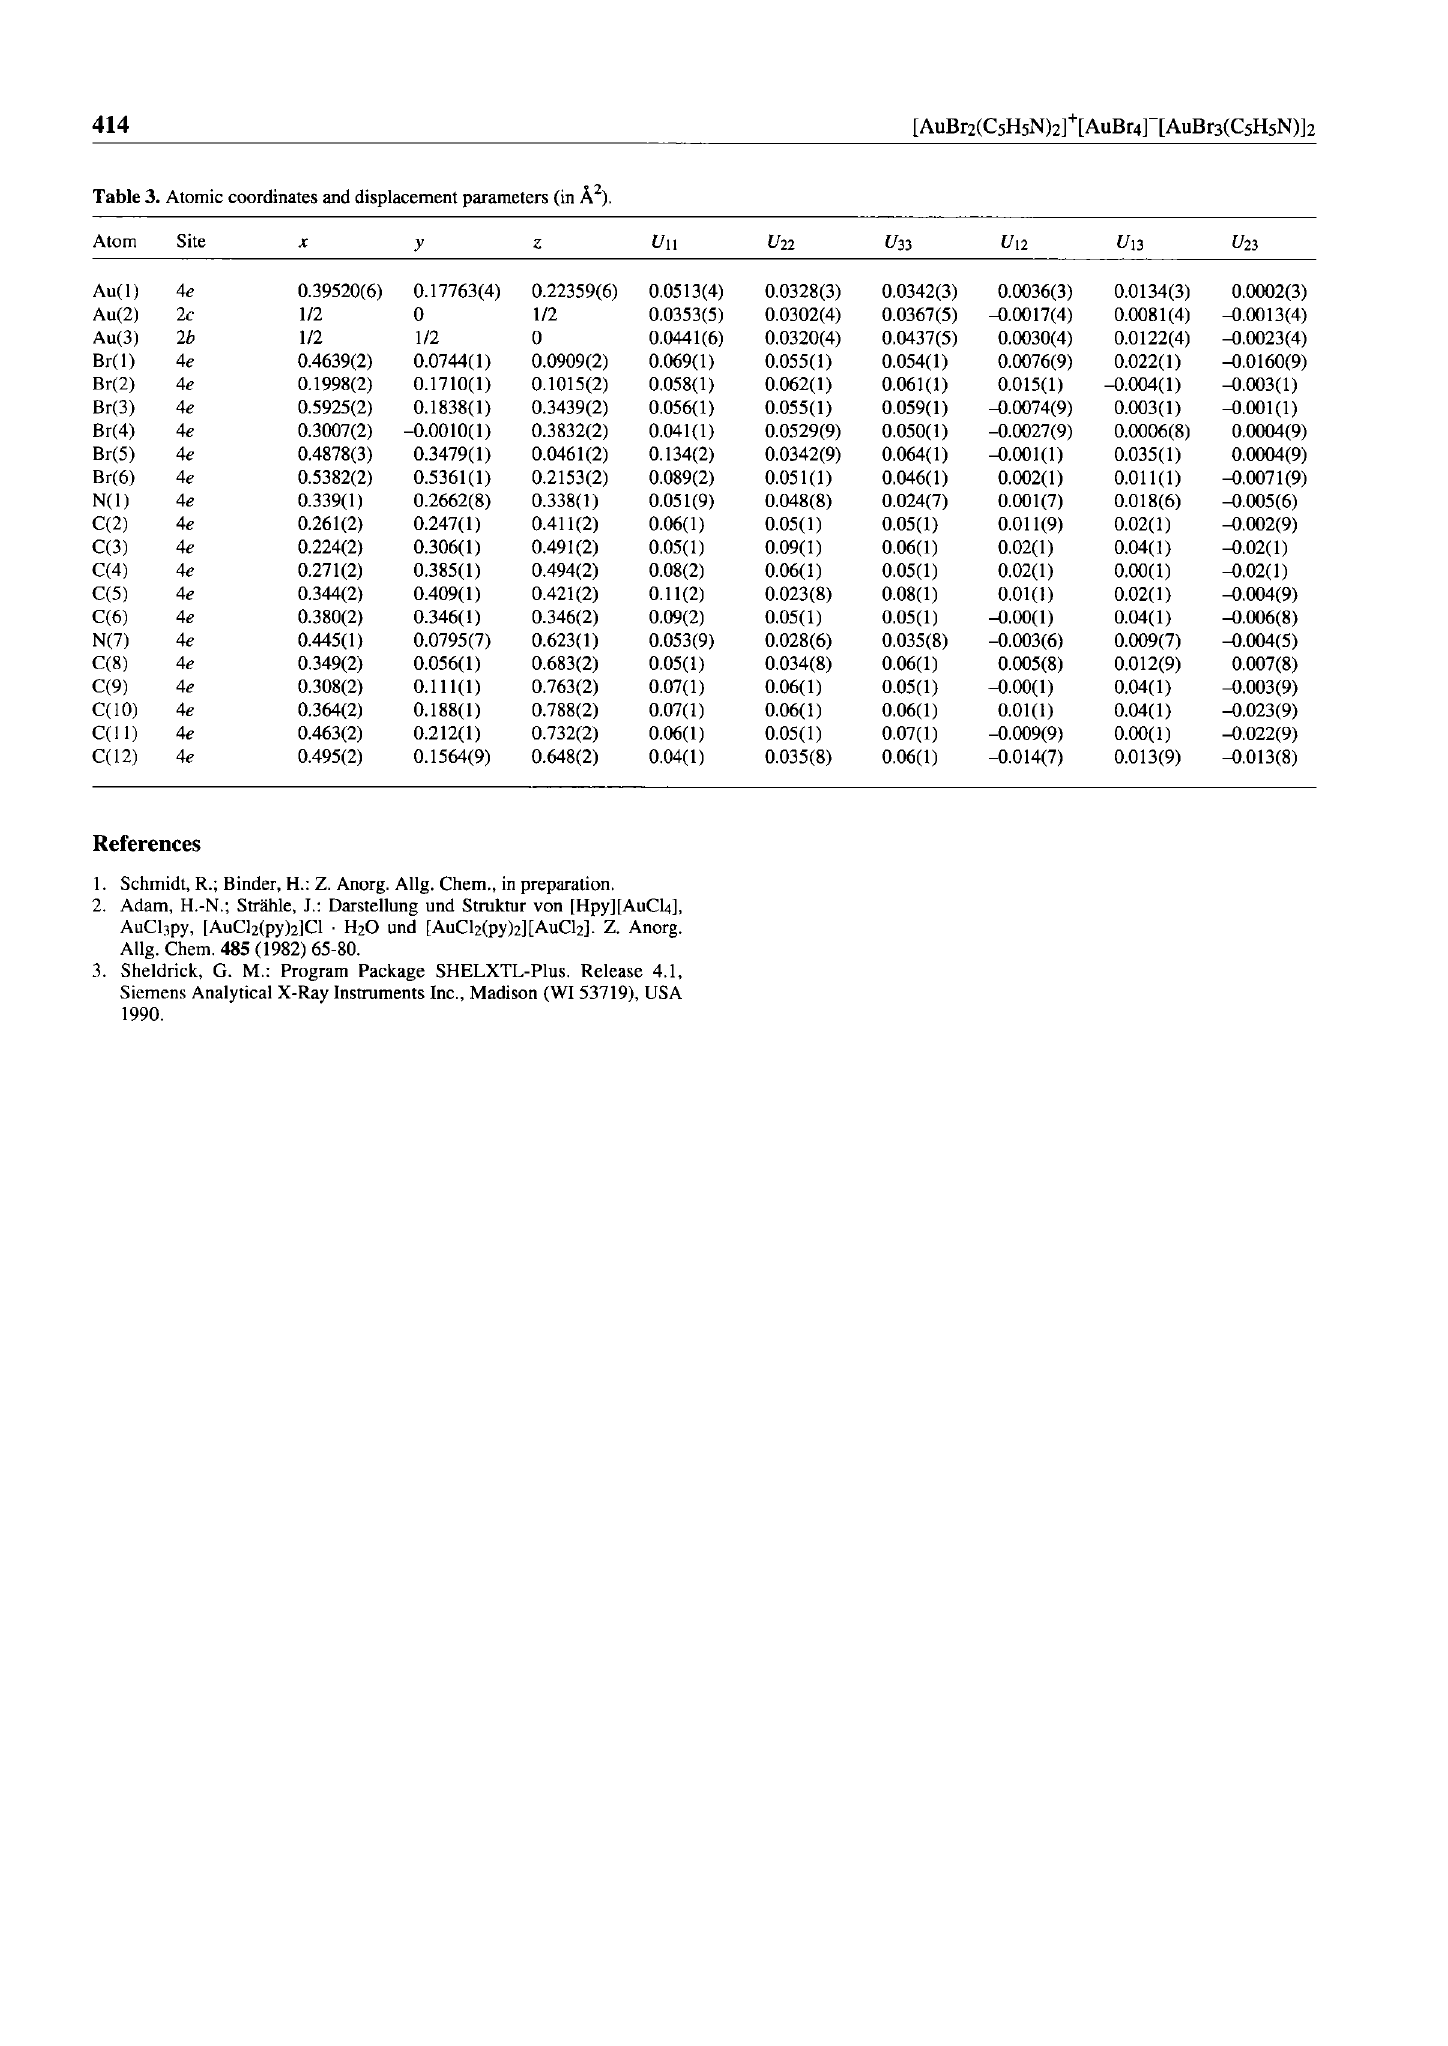
Table 3. Atomic coordinates and displacement parameters (in Ä 2